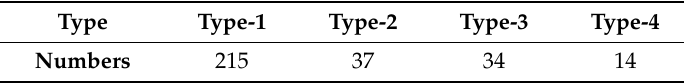
Table 1. Numbers of power usage patterns in each type.